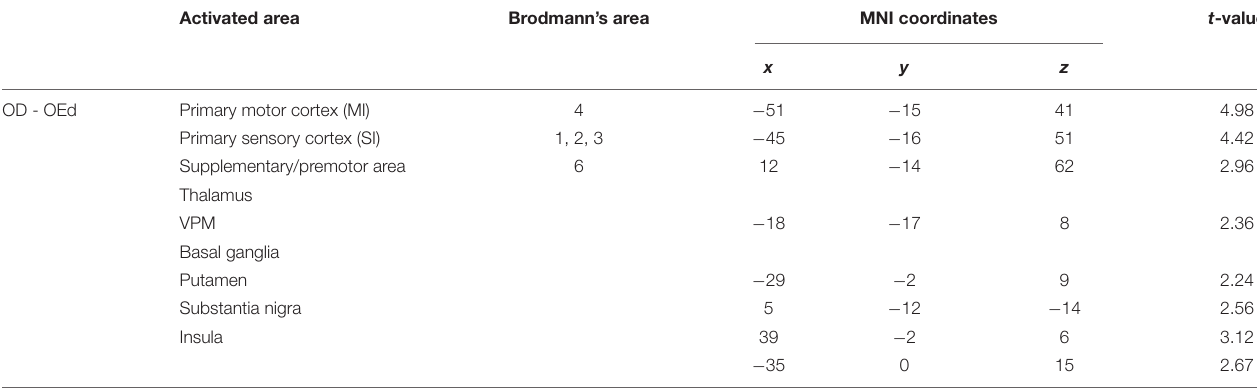
TABLE 2 | Significantly activated regions during tapping (OD >